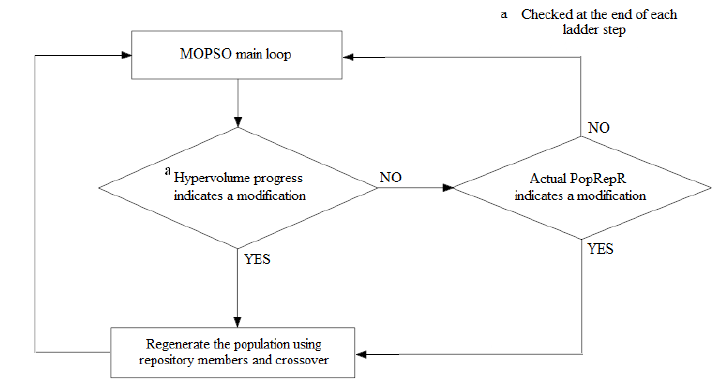
Figure 2. Flowchart describing the population regeneration